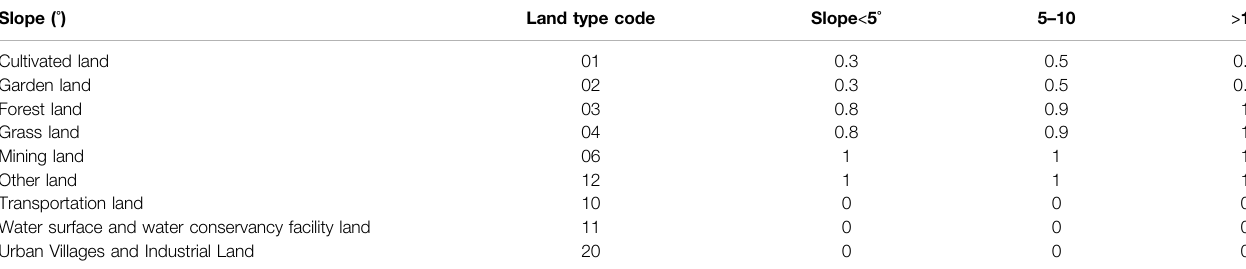
TABLE 3 | P values of different land use types in the upper reaches of Minjiang river. Slope ( °